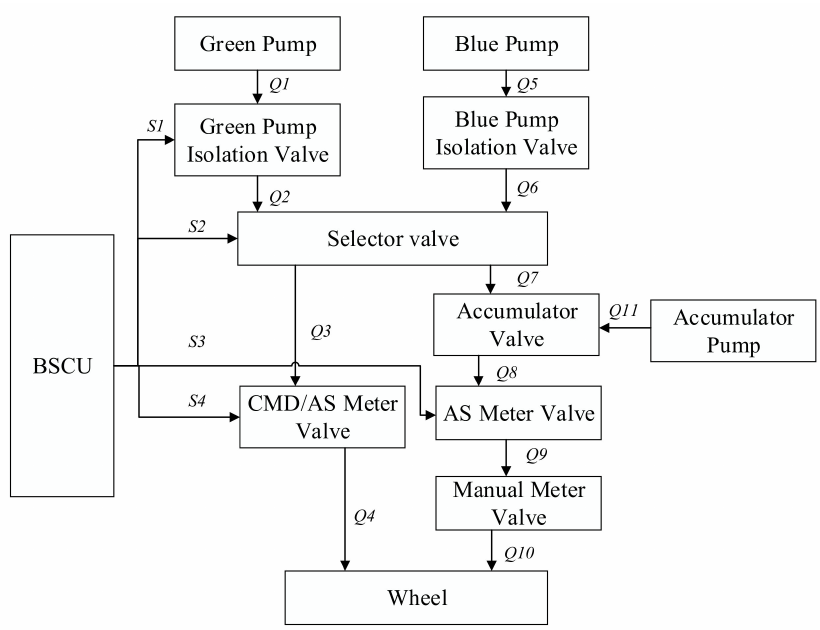
Figure 3. Structure Model of Brake System. ( Q 1 – Q 11 : the flow of the components; S 1 – S 4 : the signal of the components.)